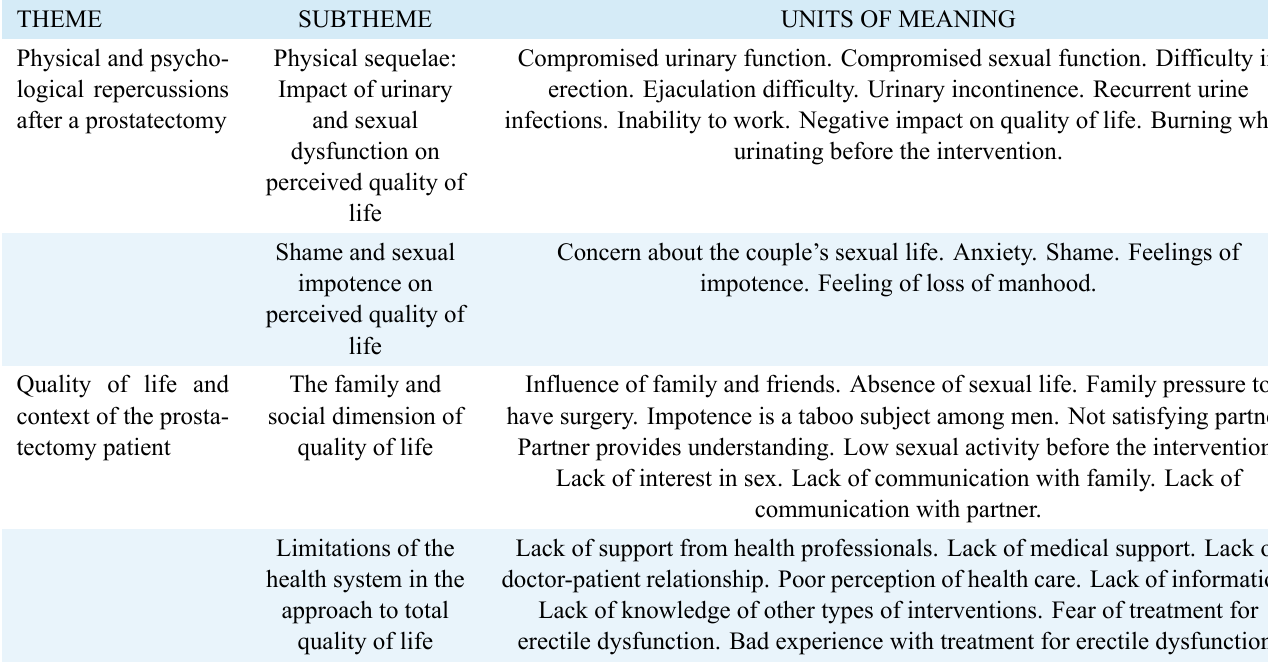
TABLE 3. Themes, subthemes and units of